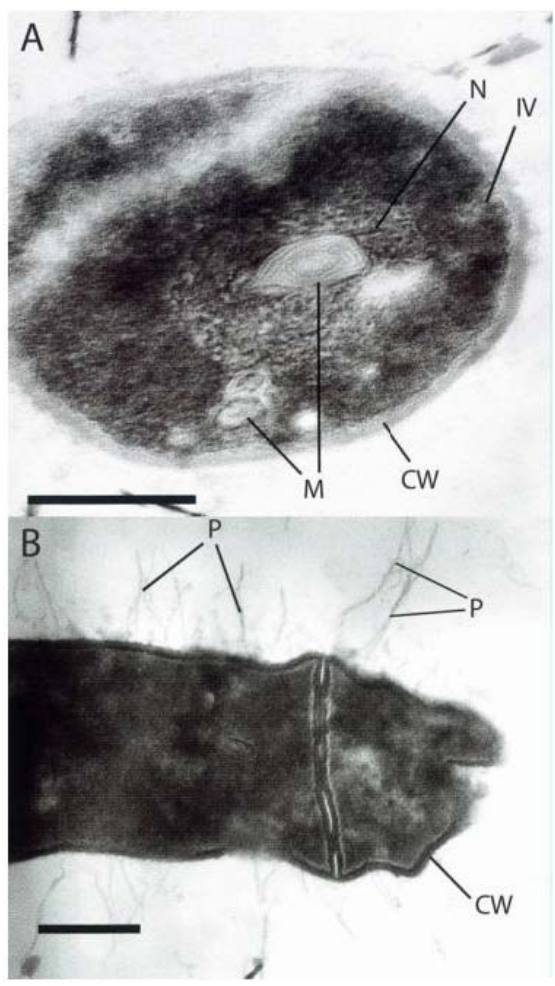
FIGURE 9. Thin-sectioning TEM showing a cell of mutant M5b (A) and M2b (B) after staining with OsO 4 . Extracellular polymer (P) is absent in M5b, whereas it appears very weakly expressed on the cell surface of M2b. The cell wall (CW) of M2b is perforated or noncontinuous, and cell division has occurred near the polar position producing a smaller cell that appears devoid of chromosomal material. Membrane-bound invaginations (IV) and mesosome-like structures (M) appear more prominent in M5b. The largest of these is shown located within the nucleoid (N). Bar = 0.25 µ